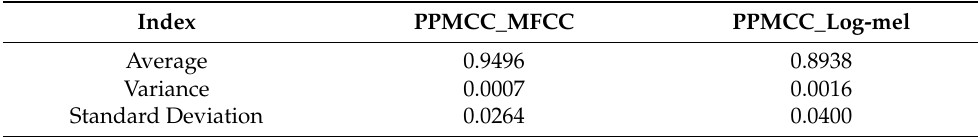
Table 4. Comparison of PPMCC with different features.